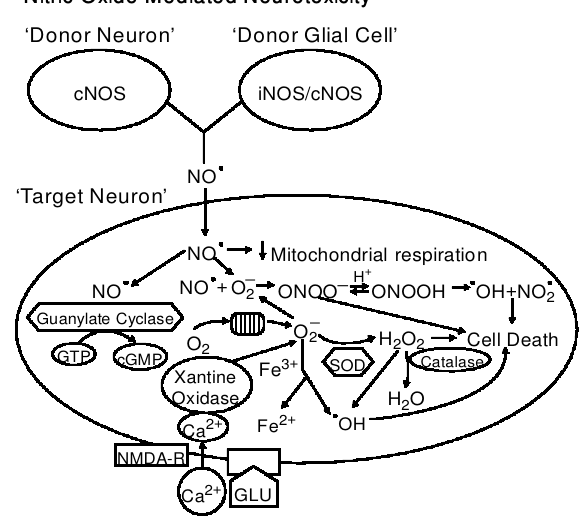
FIG. 4. NO as neurotoxin. Excessive NO is formed on sustained glutamate stimulation of NMDA receptors by cNOS in neurones or by activation of iNOS or cNOS in glial cells. NO freely diffuses to adjacent target neurones where it combines with the O 2– to yield the peroxynitrite, ONOO – , which is an extremely potent oxidant. Although NO can function as a toxin directly, the peroxynitrite pathway may be the major pathway of cell death, adapted from Ref.